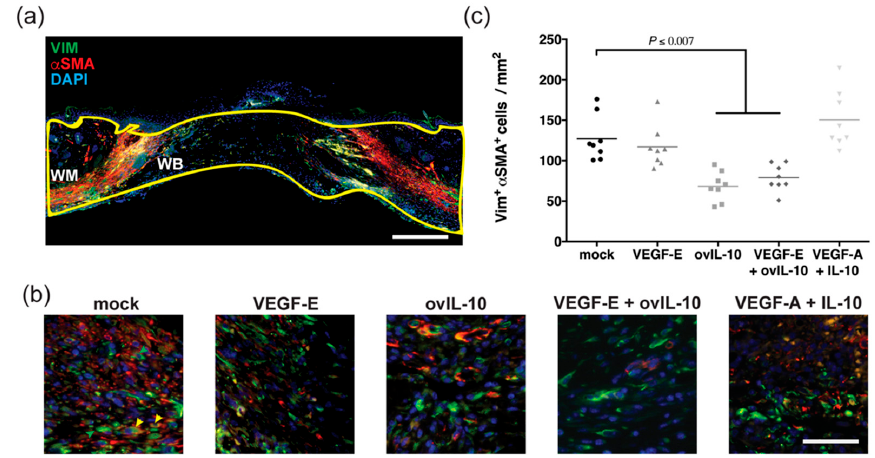
( a ) Representative image of a day 6 wound section stained with antibodies to vimentin (green) and α SMA (blue) and the nuclear stain DAPI (blue). The wound margin (WM) and wound bed (WB) are outlined with a yellow line. Scale bar = 300µm. ( b ) Representative images of the WM adjacent to the WB in day 6 wound sections after two SC injections of the indicated treatment. Co-stained myofibroblasts are indicated by yellow arrows. Scale bar = 50 µm. ( c ) The number of vimentin + ve α SMA +ve myofibroblasts within the WM and WB at day 6 post-wounding. Data are presented with each symbol representing an individual wound, and the line indicating the mean of 8 wounds. P values are indicated.